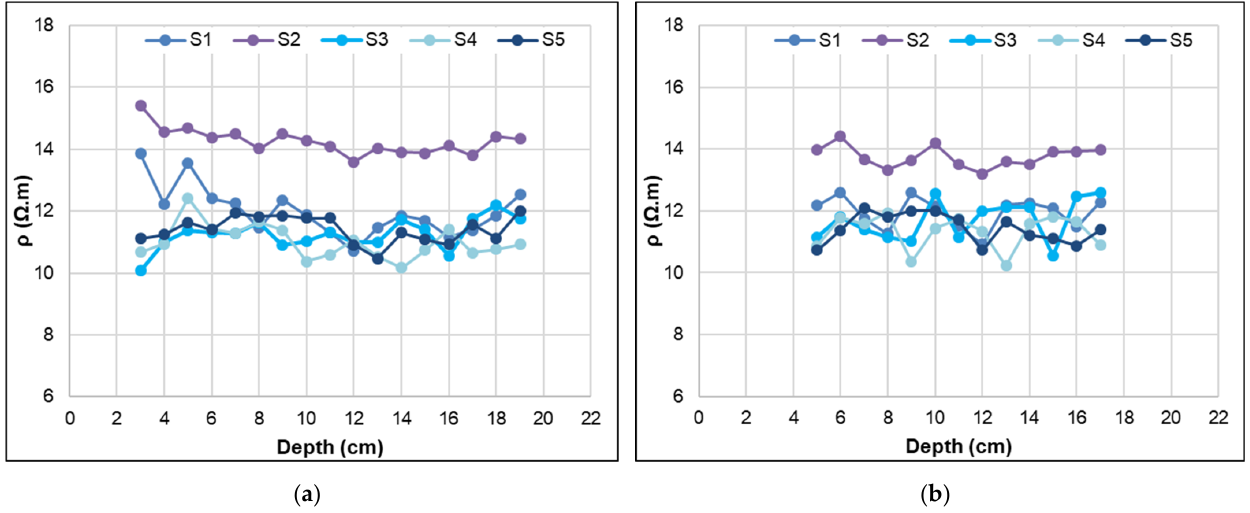
Figure 3. Resistivity profiles over depth in saturated conditions ( Sr = 95.0 ± 2.0%) at temperature T = 20 ± 2 °C for all the specimens: ( a ) transmission configuration; ( b ) Wenner configuration [26]. Second, a study of the variation of the resistivity profiles was carried out for all the specimens at different degrees of saturation ( S r = 72.2 ± 1.0%, 53.3 ± 0.3%, and 33.8 ± 0.5%) for both the transmission and Wenner configurations.